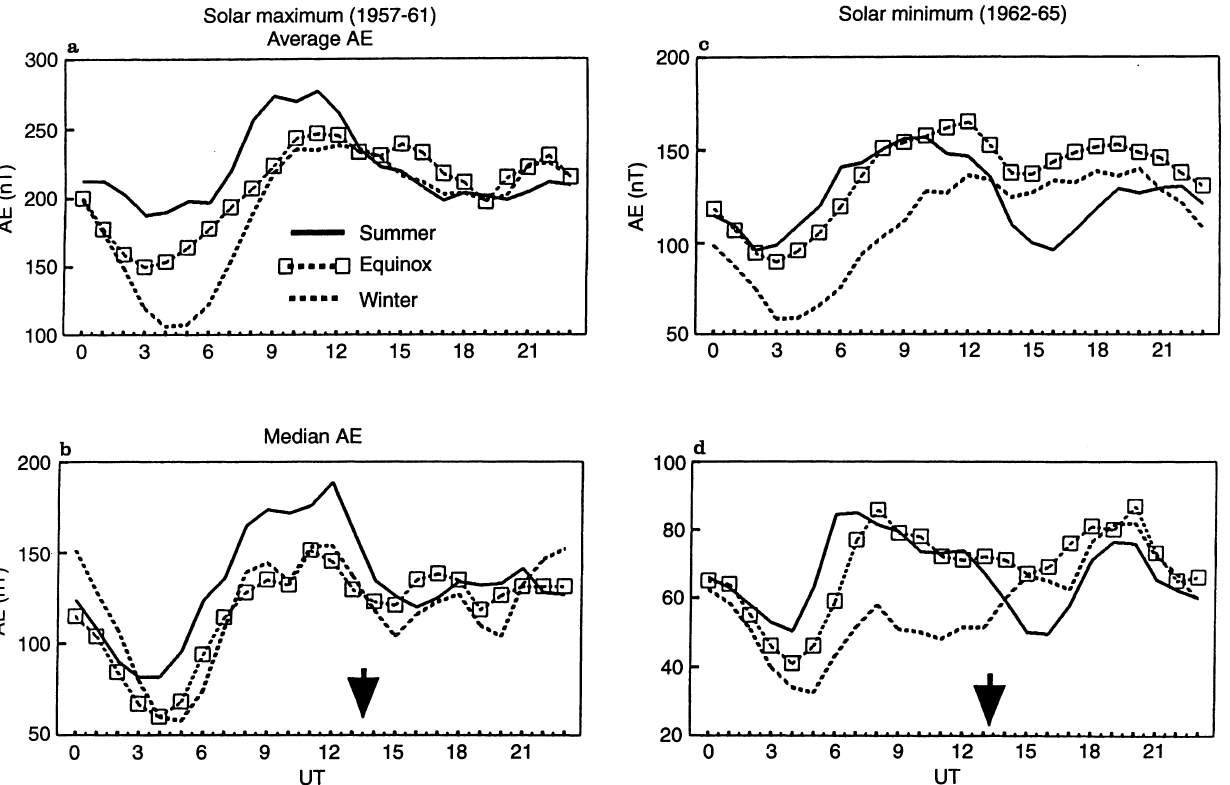
Fig. 3a–d. Average and median trends in the hourly AE-index (complete data) at di(cid:128)erent seasons at sunspot maximum and minimum. The standard errors (not shown for clarity) did not exceed 10% of the nominal AE values (the same applies to other